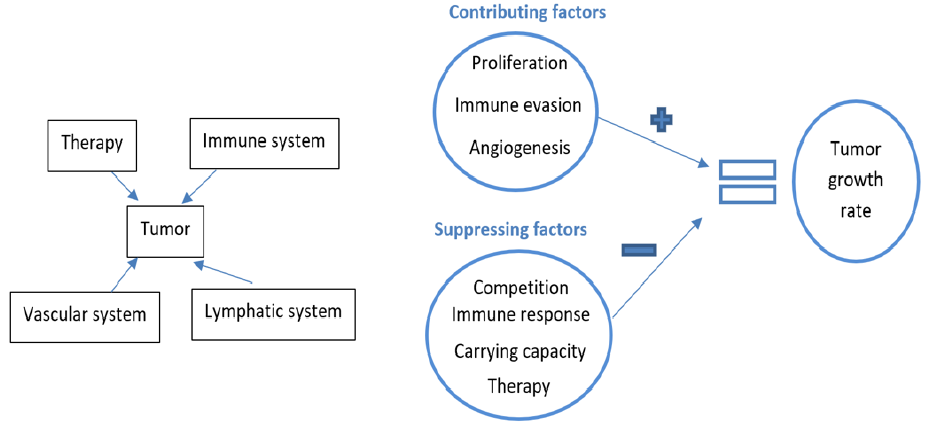
Figure 6. Factors influencing tumor dynamics.